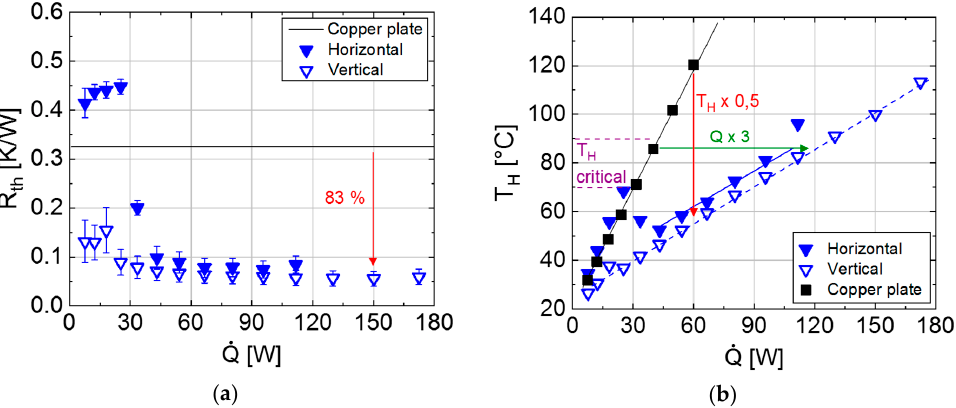
Figure 5. Results for PHPs with channel size of 1.5 × 1.5 mm 2 with water cooling for horizontal and vertical orientation for heating powers up to 180 W, compared to a solid analogous copper plate. ( a ) Plot of thermal resistance R th vs. heating power ´ Q . Red arrow: reduction in R th compared to copper plate; ( b ) plot of heater temperature T H vs. heating power ´ Q . Red arrow: heater temperature of heater on PHP relative to copper plate at the same heating power. Green arrow: heating power of heater on PHP relative to copper plate at the same temperature of ca. 80–90 ◦ C, which is a critical temperature not to be exceeded for many electronic parts.